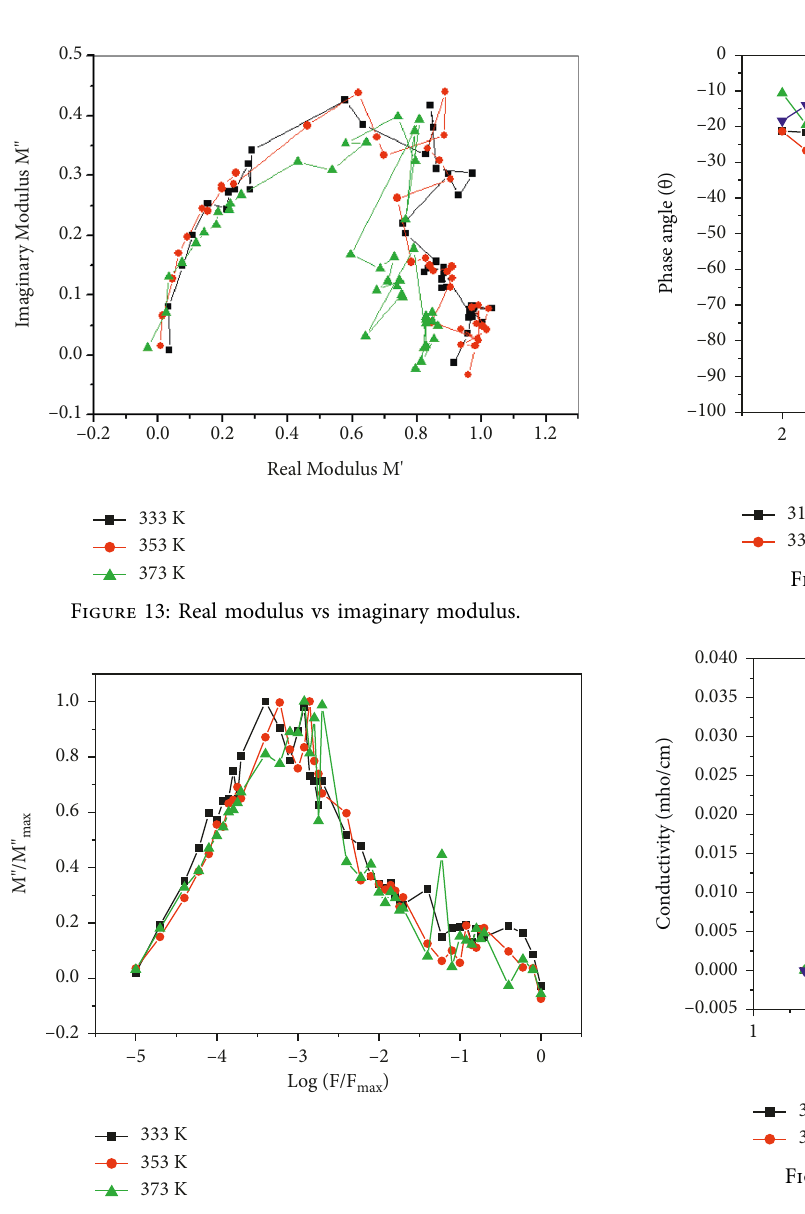
Figure 14: Normalized curve of M’/M’‘max versus log (F/Fmax).